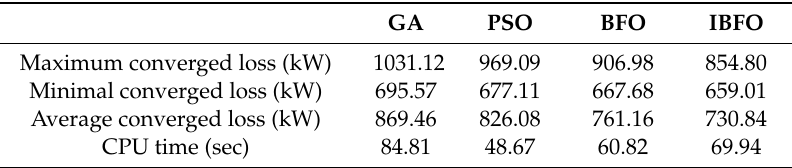
Figure 10. The convergence characteristics of genetic algorithm (GA), particle swarm optimization (PSO), bacterial foraging optimization (BFO), and IBFO. Table 4. The comparison of GA, PSO, BFO, and IBFO.